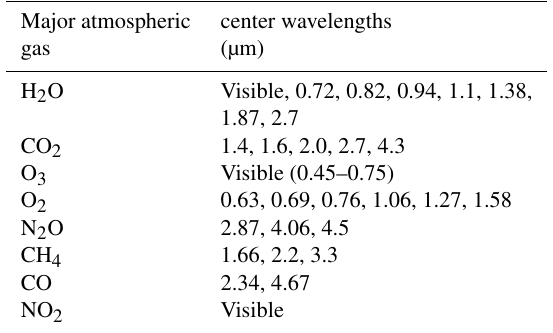
Table 1. Absorption bands of atmospheric gases in visible and near- IR